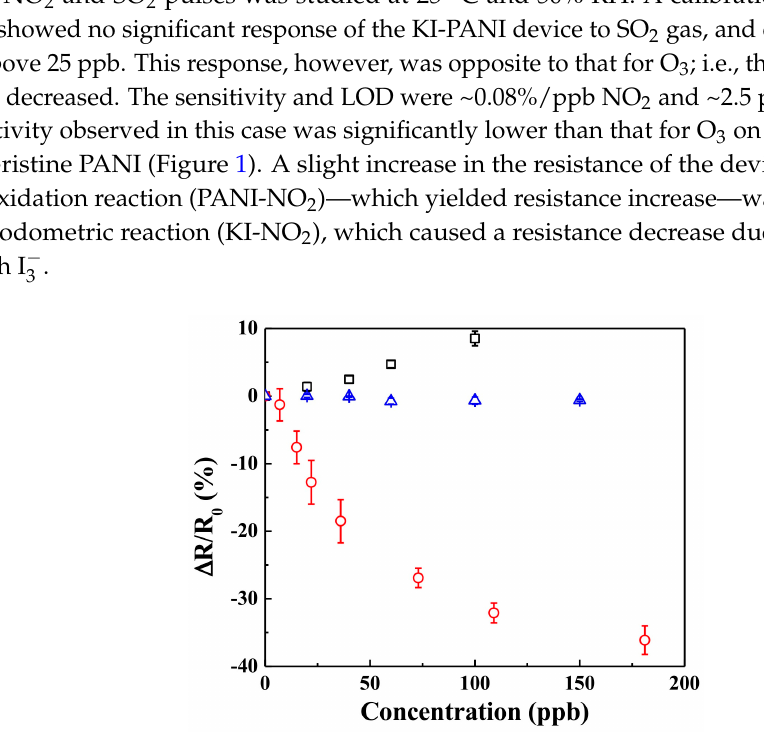
Figure 4. Selectivity of KI-PANI sensor towards O 3 (red/ ○ ) with respect to other interfering analytes NO 2 (black/ □ ) and SO 2 (blue/ ∆ ) in terms of sensing response ( ∆ R / R 0 ) at various analyte concentrations. Data points are average of responses from three independent sensors, and error bars represent ±1 standard deviation.